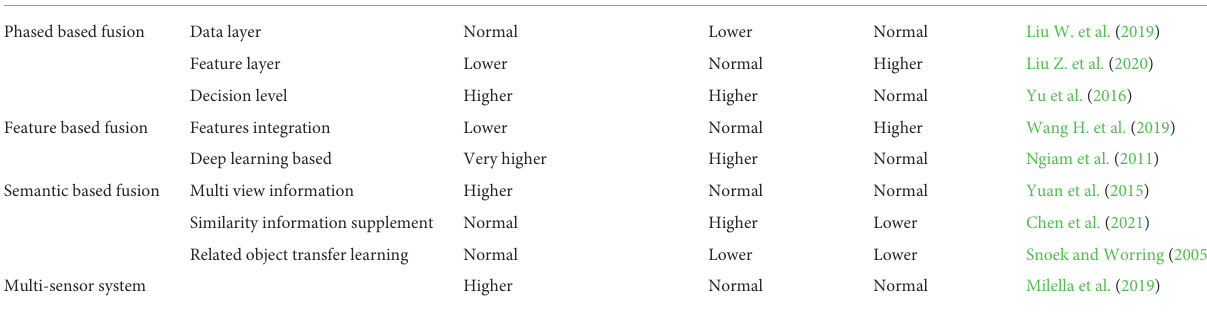
TABLE 8 Comparison of model fusion